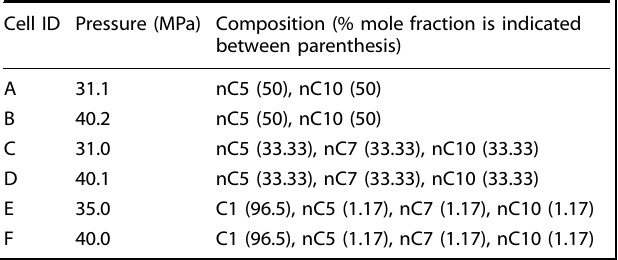
Table 1. Composition and pressure of the six SCCO cells embarked in SJ-10 Cell ID Pressure (MPa) Composition (% mole fraction is indicated between parenthesis)